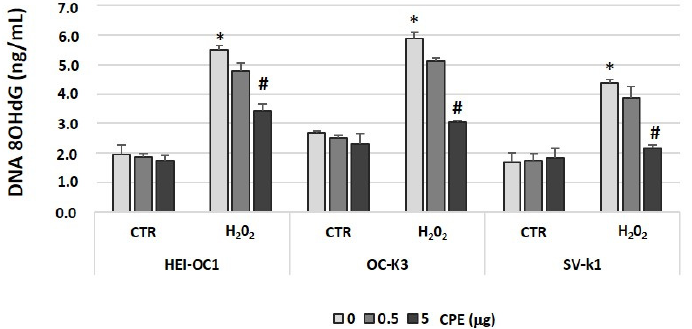
Figure 5. Cocoa extract prevented H 2 O 2 -induced DNA oxidative damage in senescence auditory cells. The 8-OHdG activities were measured by a colorimetric assay in protein lysates of HEI-OC1, OC-k3, and SV-k1 cells post-treatments. Experimental groups: CTR group (0, 0.5 and 5 μ g/mL of CPE for 20 h) and H 2 O 2 group (induced cellular senescence with 100 μ M for 1 h in all groups: 0, 0.5 and 5 μ g/mL of CPE for 20 h). The values represent the mean ± SD in triplicate. * p < 0.05 vs. CTR group; # p < 0.05 vs. H 2 O 2 group ( n = 4).